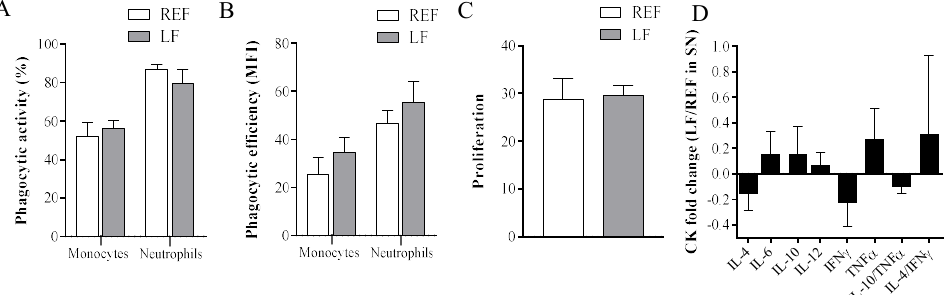
Figure 1. Systemic and intestinal immune cell function of dams at L14. The ( A ) phagocytic activity and ( B ) phagocytic e ffi ciency of blood monocytes and neutrophils was measured. Moreover, ( C )